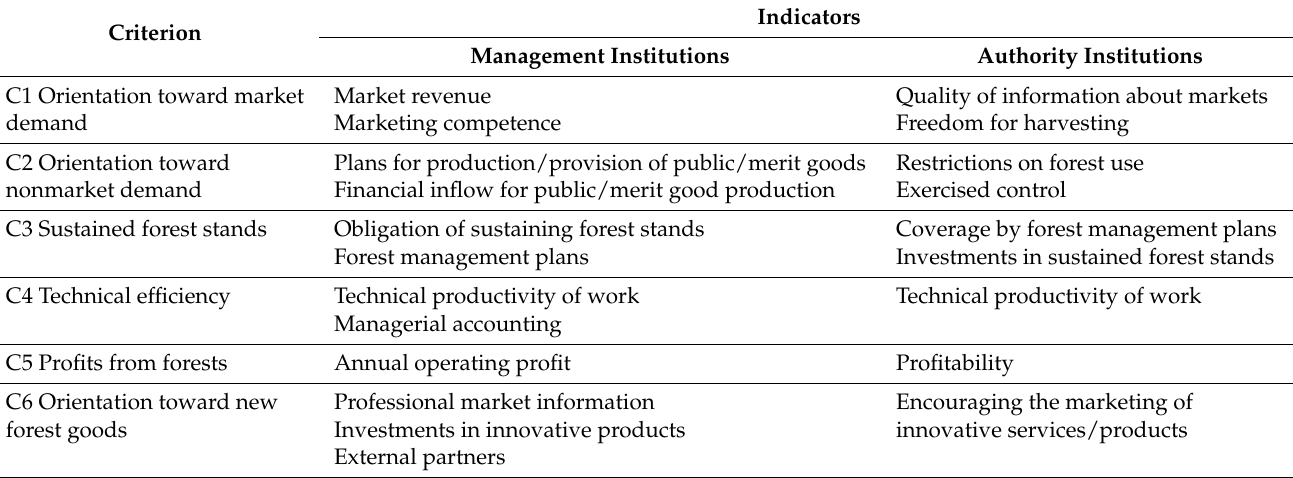
Table 1. Criteria and indicators used to evaluate state forest institutions’ performance (based on [34,35]).